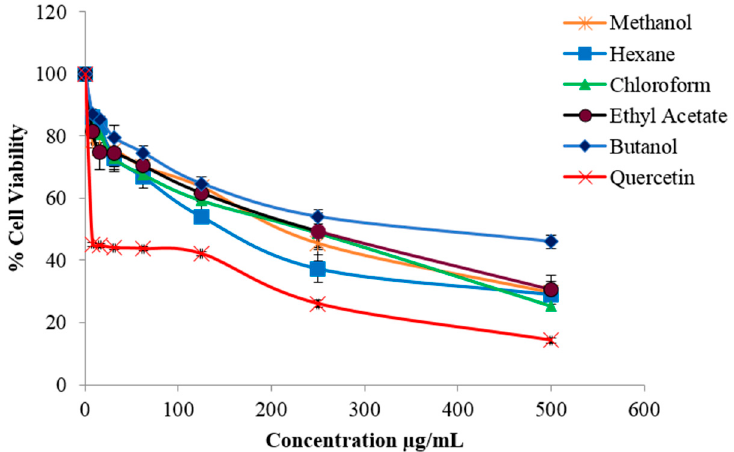
Figure 1. Cytotoxic effect of various fractions of Z. rhetsa , at different concentrations (0–500 µg/mL), against B16-F10 melanoma cells. Data are expressed as mean ± SD of three independent experiments. Quercetin was used as the positive control.